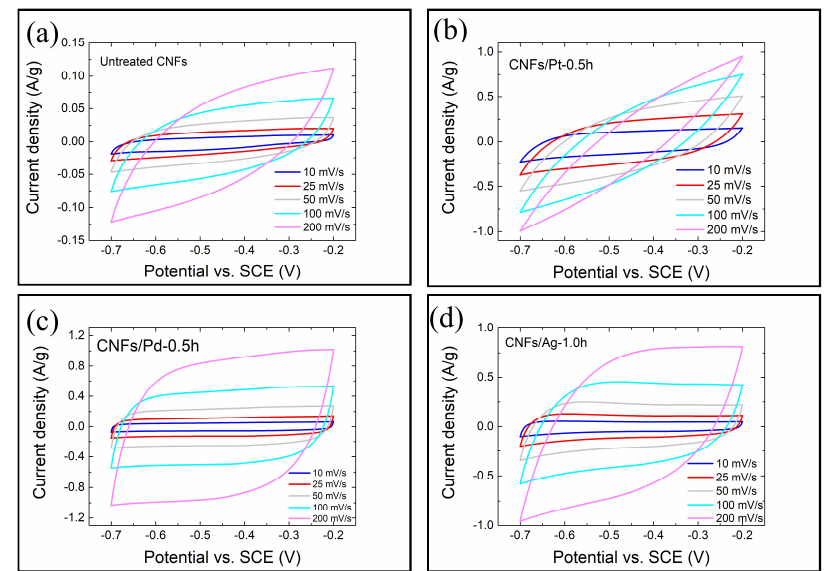
Figure 4. Typical cyclic voltammograms for electrodes made of: ( a ) untreated CNF; ( b ) CNFs/Pt-0.5h; ( c ) CNFs/Pd-0.5h and ( d ) CNFs/Ag-1.0h.